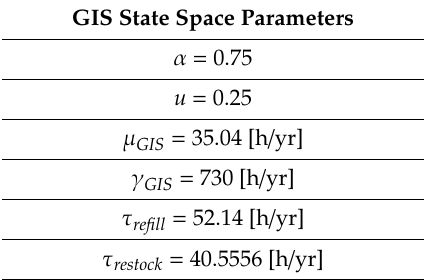
Table 1. Parameters of the GIS state space diagram of Figure